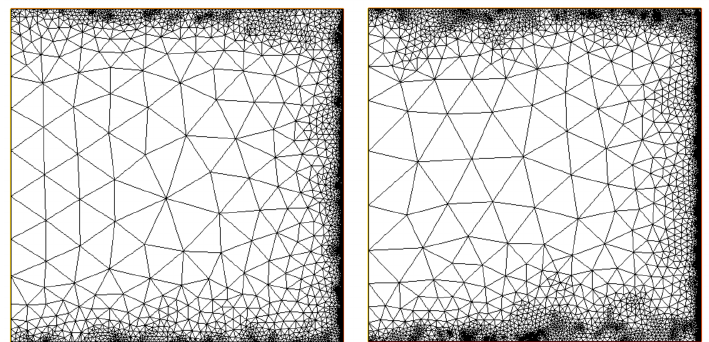
Figure 22. Example 4: results with the residual-based error estimator. ( Left ) The final mesh obtained by using c = auto is shown. ( Right ) The final mesh with c = 0.3.